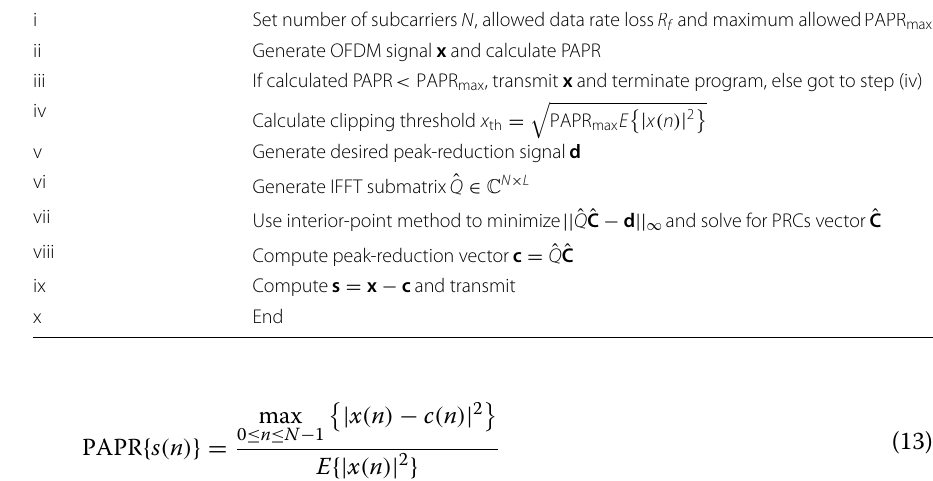
Table 1 Proposed TR